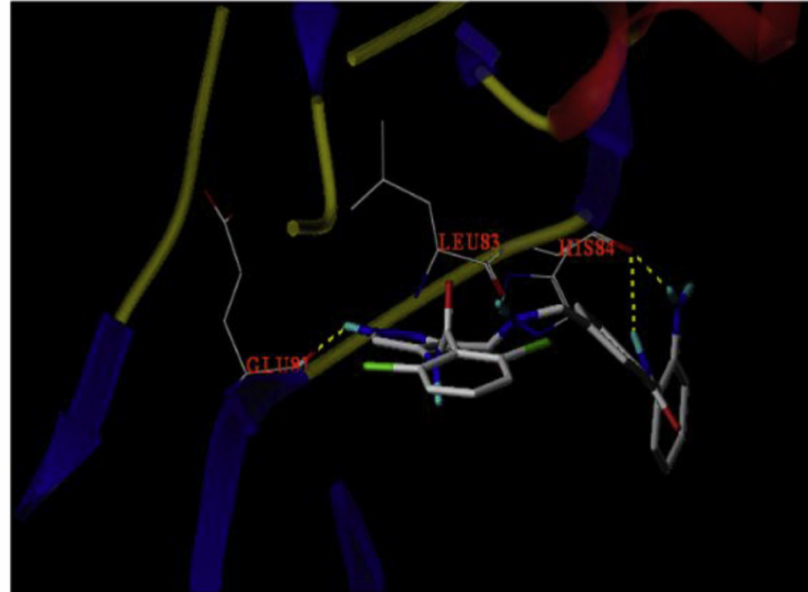
Figure 30. Docking pose of compound 27 into the crystal structure of CDK2